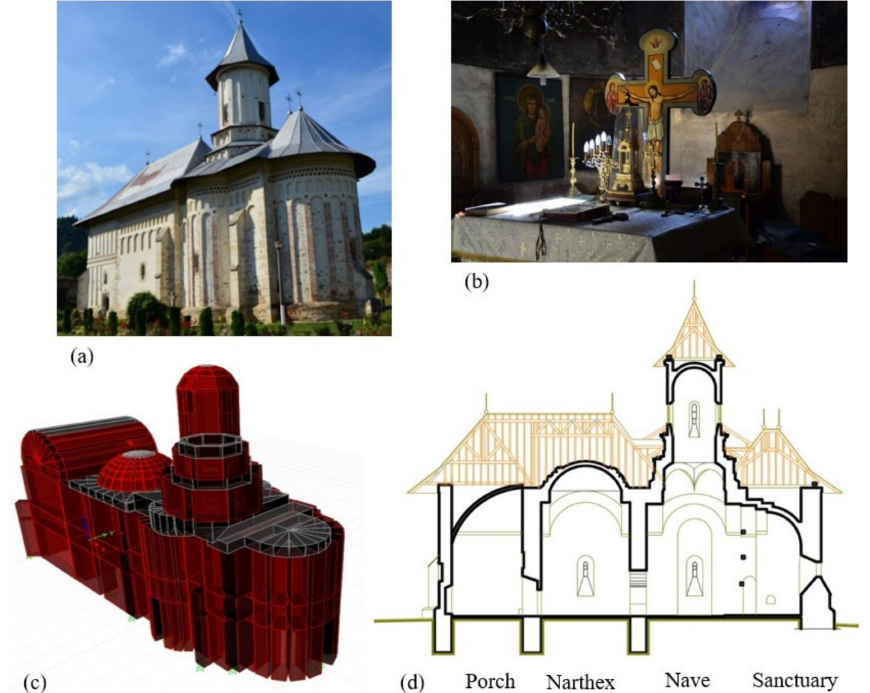
Figure 1. Tazl ă u monastery: ( a ) The church of the Nativity of the Blessed Virgin Mary of Tazl ă u monastery, ( b ) Sanctuary and altar table, ( c ) 3D model—isometric view, ( d ) Longitudinal section and arrangement of